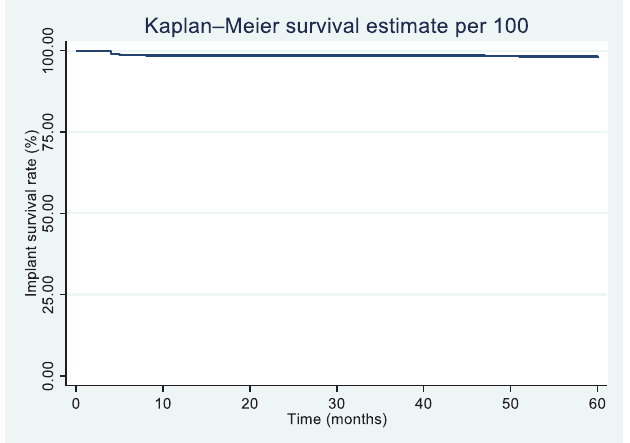
Fig. 3. Kaplan Meier survival curve showing the success rate for implants with good primary stability. Table I. Cumulative survival rates for zero torque implant placement.